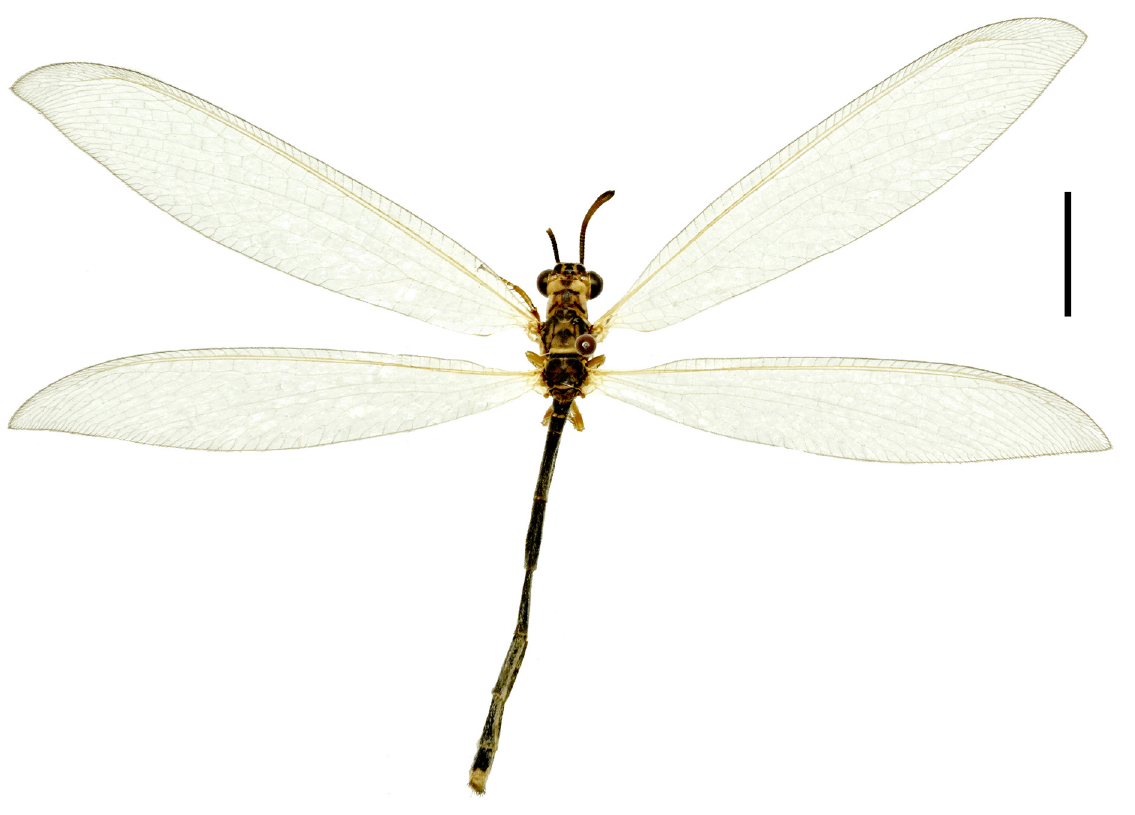
Fig. 12. Myrmeleon hyalinus hyalinus Olivier, 1811 (CAUPK000024). Male, dorsal habitus. Scale bar = 0.5